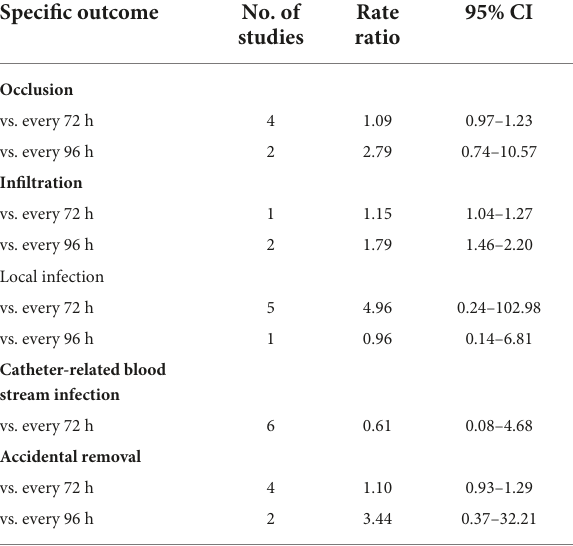
TABLE 2 Subgroup analysis according to the schedule of routine replacement of peripheral intravenous